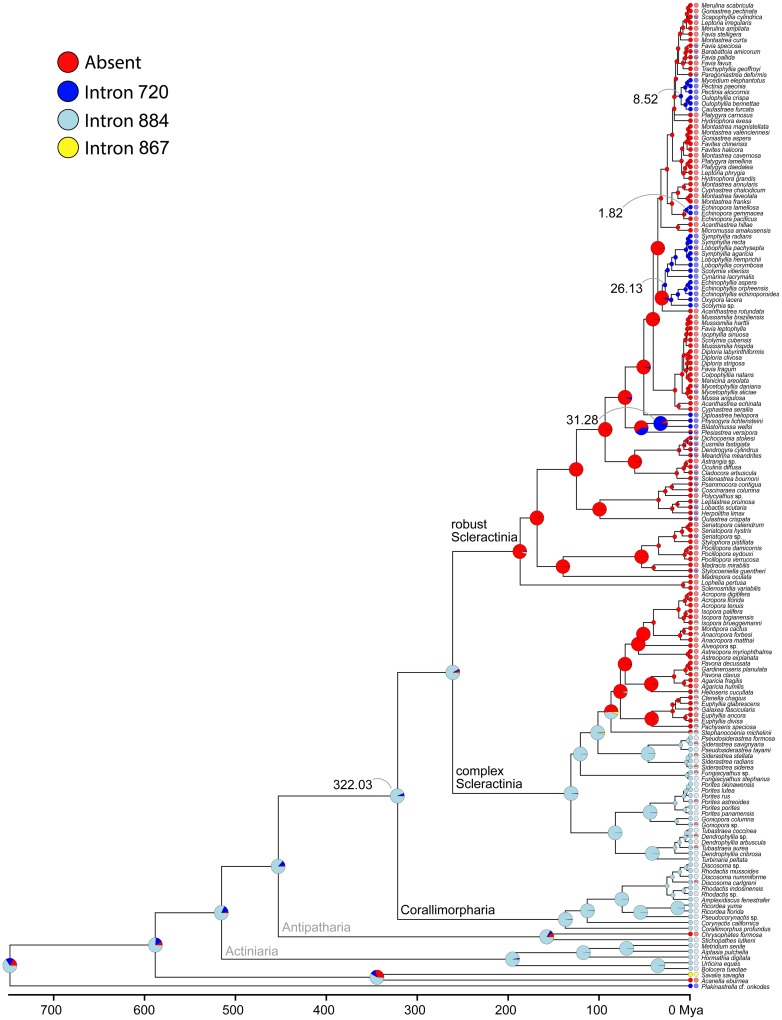
Bayesian stochastic character mapping of intron type in major cnidarian groups.The translucent pie charts portray the prior information about intron type used for the analysis. Single colored circles indicate known intron presence/absence, whereas in the case of unknown intron state proportions of pie charts display the respective prior probability. Solid colored pie charts show inferred posterior probabilities of intron state at internal nodes and tips.